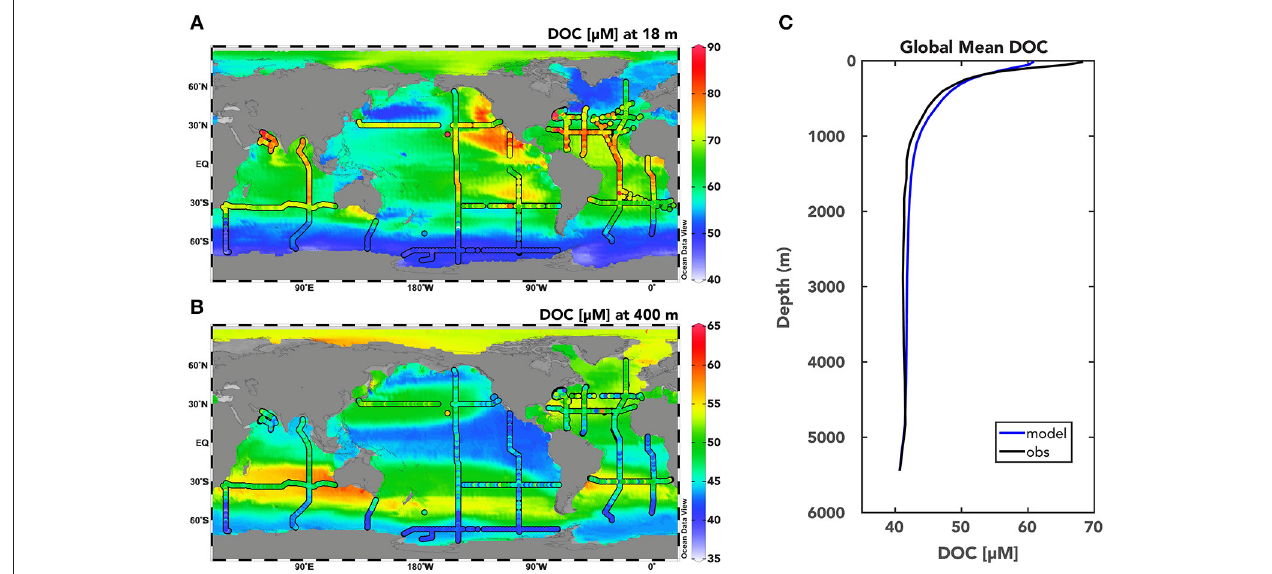
FIGURE 2 | Modeled DOC distributions from the global ocean DOC cycling inverse model with Model I DOC cycling. Model simulated total DOC concentrations [ µ M] (DOC SL + DOC SR + DOC R ) are plotted for the euphotic zone at 18m (A) and within the mesopelagic zone at 400m (B) from the solution to the Model I DOC cycling case with Redfield r CP of DOM production (see Methods for details). Observations of total DOC from the global database at each depth are shown with the colored dots. (C) Global mean simulated (blue) and observed (black) depth profile of DOC concentrations [ µ M].